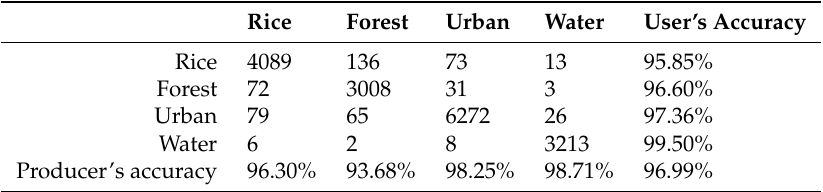
Table 1. Confusion matrix of land-use types using random